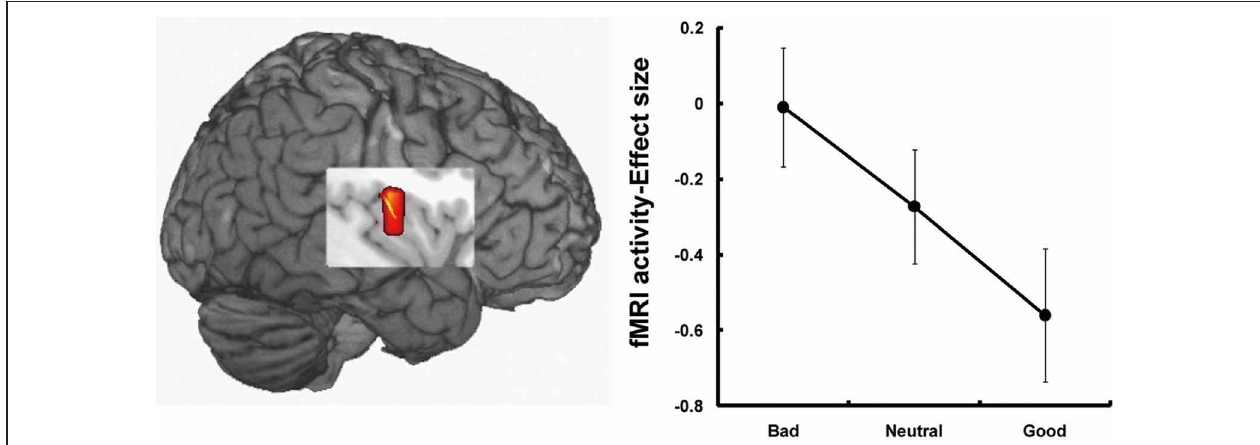
FIGURE 3 | Insular activations in response to untrustworthyfaces (Tsukiura et al., 2012). Activity of the insular cortex was greater during the processing of faces with an impression of untrustworthiness. This figure was reused with the permission.